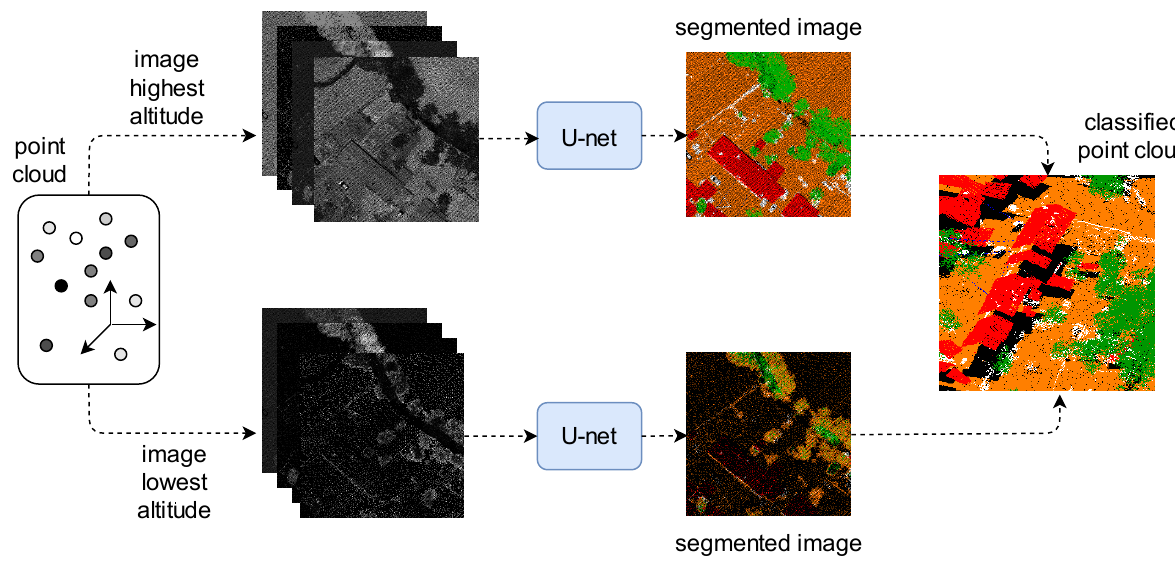
Figure 2. Workflow of the proposed method. At first, the point cloud is projected to multi-channel images. Images are then segmented by a FCN (U-net) that assigns a label to each pixel and, consequently, to each point. Table 1. Number of points for the training/validation and test sets, divided according to the five